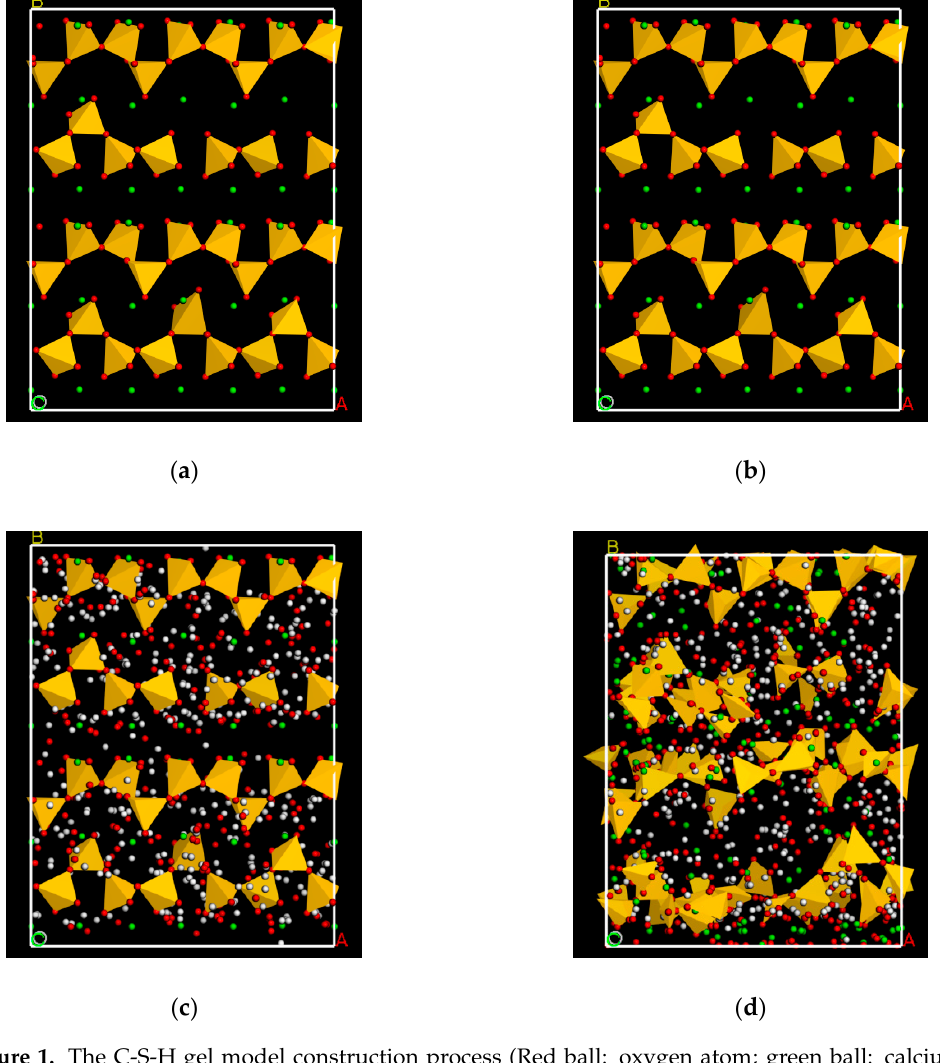
Figure 1. The C-S-H gel model construction process (Red ball: oxygen atom; green ball: calcium atom; white ball: hydrogen atom; yellow tetrahedral: silicate tetrahedral): ( a ) initial tobermorite 11 Å structure without water molecules. Cell parameters: a = 18.37 Å, b = 24.32 Å, c = 26.48 Å, α , β , γ , equal to 90 ◦ ; ( b ) removal of the bridging silicate tetrahedral, where Q n represents n species of silicate tetrahedral, n corresponds to the number of bridging oxygen atoms (BO) in one silicate tetrahedral; ( c ) grand canonical Monte Carlo (GCMC) water adsorption and ( d ) C-S-H structure finality achieved.